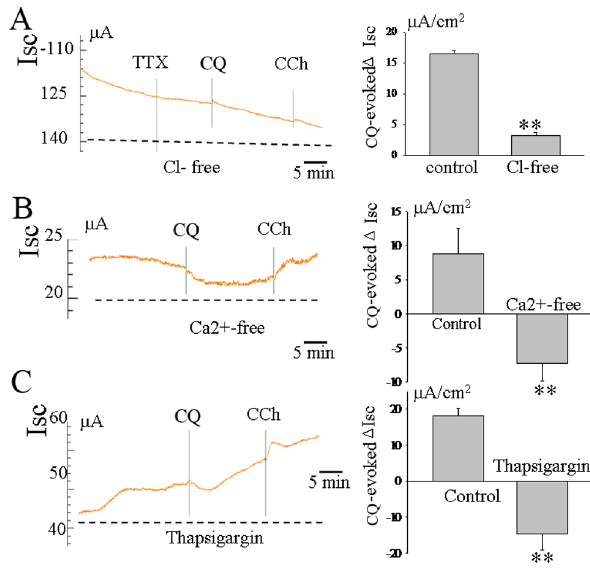
Figure 4. Effects of Cl 2 and Ca 2 + -free solution on CQ-evoked increase in I SC in rat ileum. CQ-induced increases in I SC was greatly reduced in the absence of Cl 2 (n=6,A). In the absence of Ca 2 + , CQ- induced increases in I SC were totally abolished, whereas a decrease in basal I SC was seen in this Ca 2 + -free condition(n=5,B). A similar effect was obtained in response to pretreatment with thapsigargin(10 2 6 M), a Ca 2 + pump inhibitor(n=6, C). ** P , 0.01 by unpaired t -test.